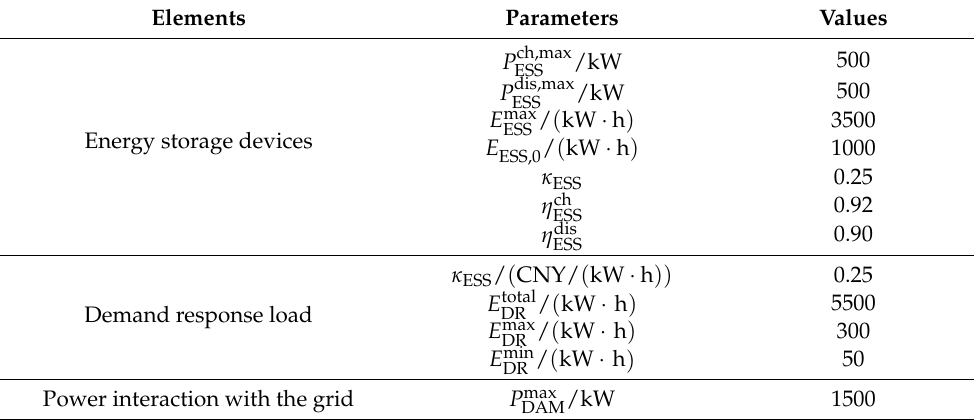
Table 4. Operating parameters of the VPP.